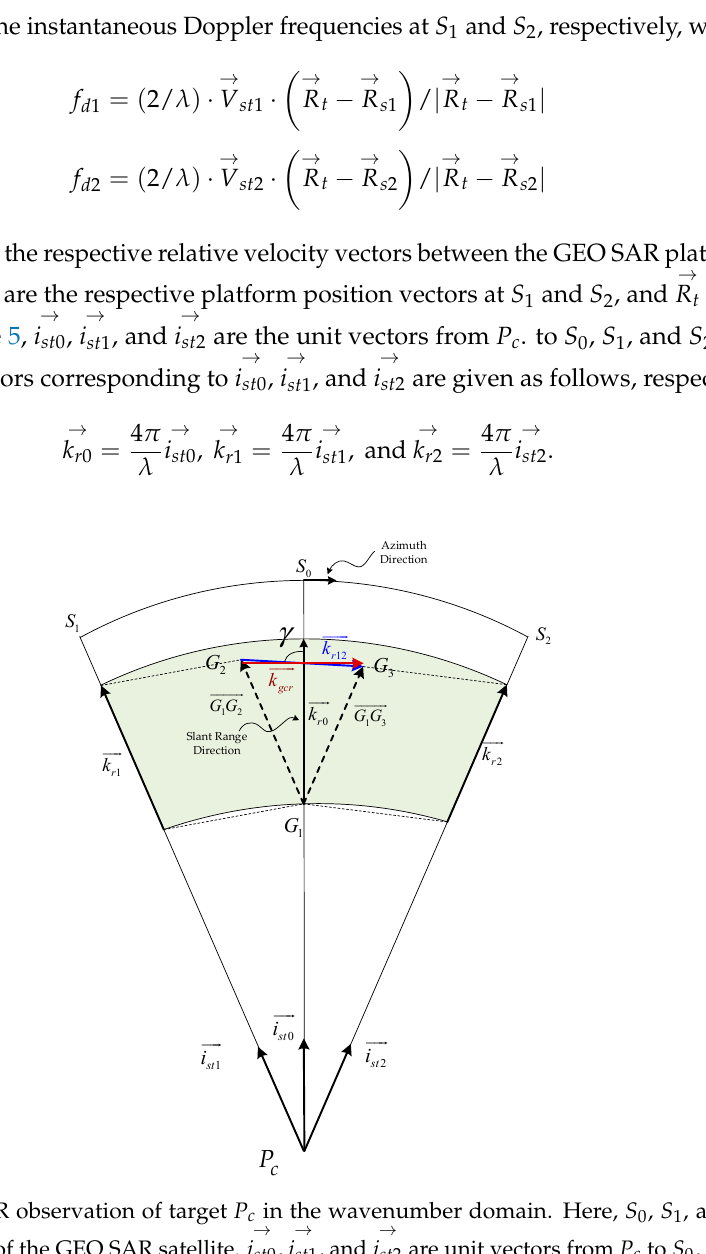
→ → → k r 2 , and | G 1 G 3 | = | k r 2 | . → k gcr is the projection of